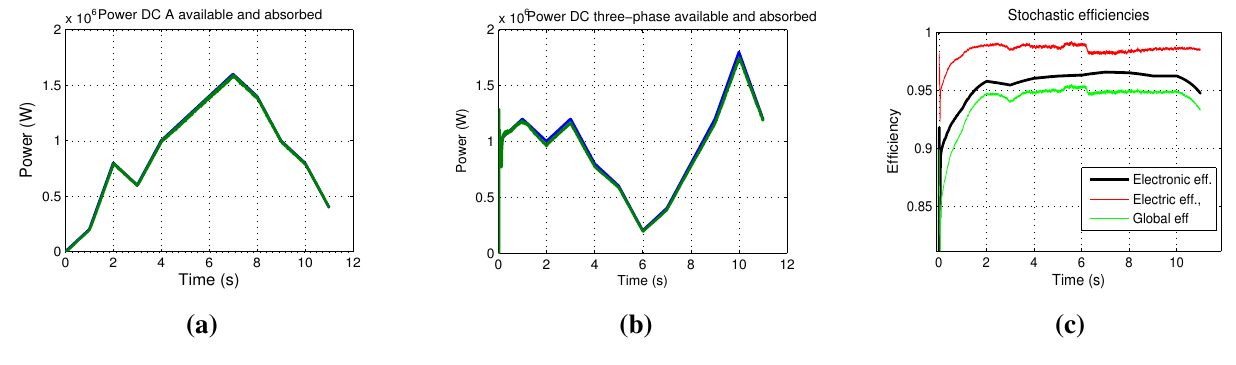
Figure 10. Simulation results for stochastic energy sources after optimization. Single-phase converter DC available power and absorbed power; ( b ) three-phase converter DC available power and absorbed power; ( c ) electronic efficiency, magnetic elements efficiency and global